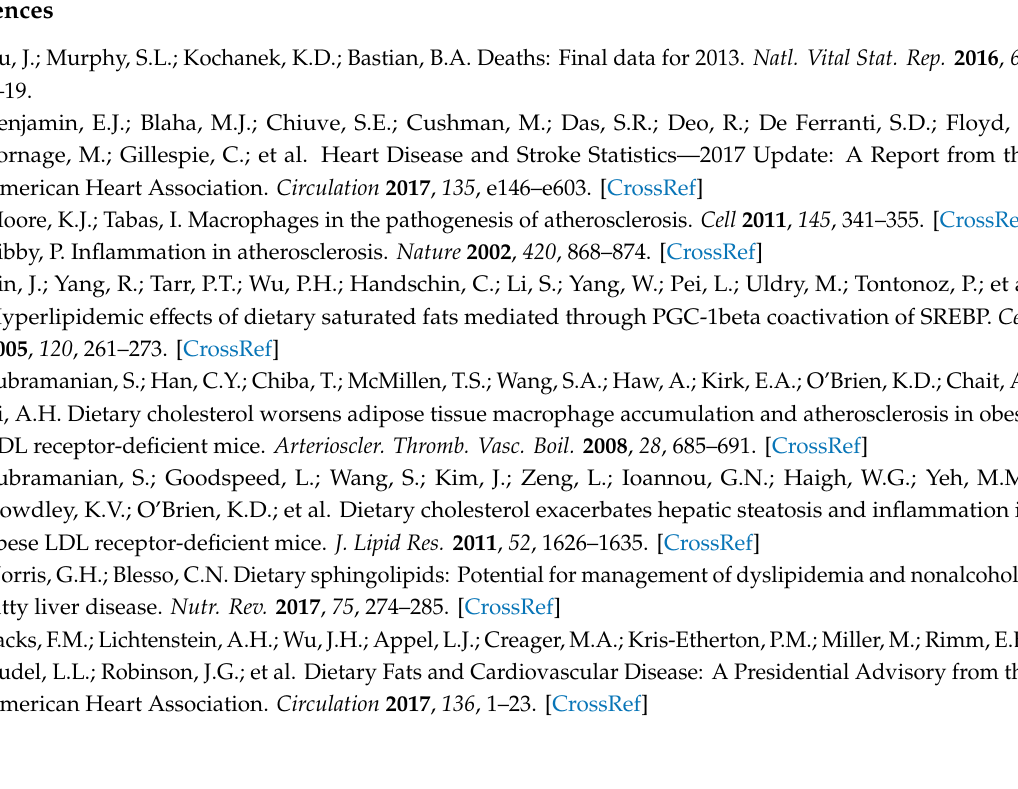
Figure S1: E ff ect of ESM on epididymal adipose gene expression, Figure S2: E ff ect of ESM on liver lipids and hepatic gene expression, Figure S3: E ff ect of ESM on cecal feces lipids and intestinal gene expression, Table S1: Composition of diets, Table S2: Primer List for